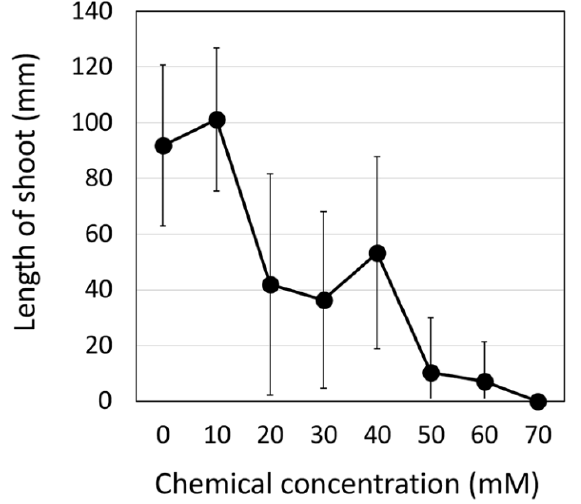
Figure 1. Effects of the different EMS concentrations on the shoot length of 14-d-old edamame Hiden seedlings. Data are expressed as the average with standard deviation (n = 30). The experiment was repeated three times.